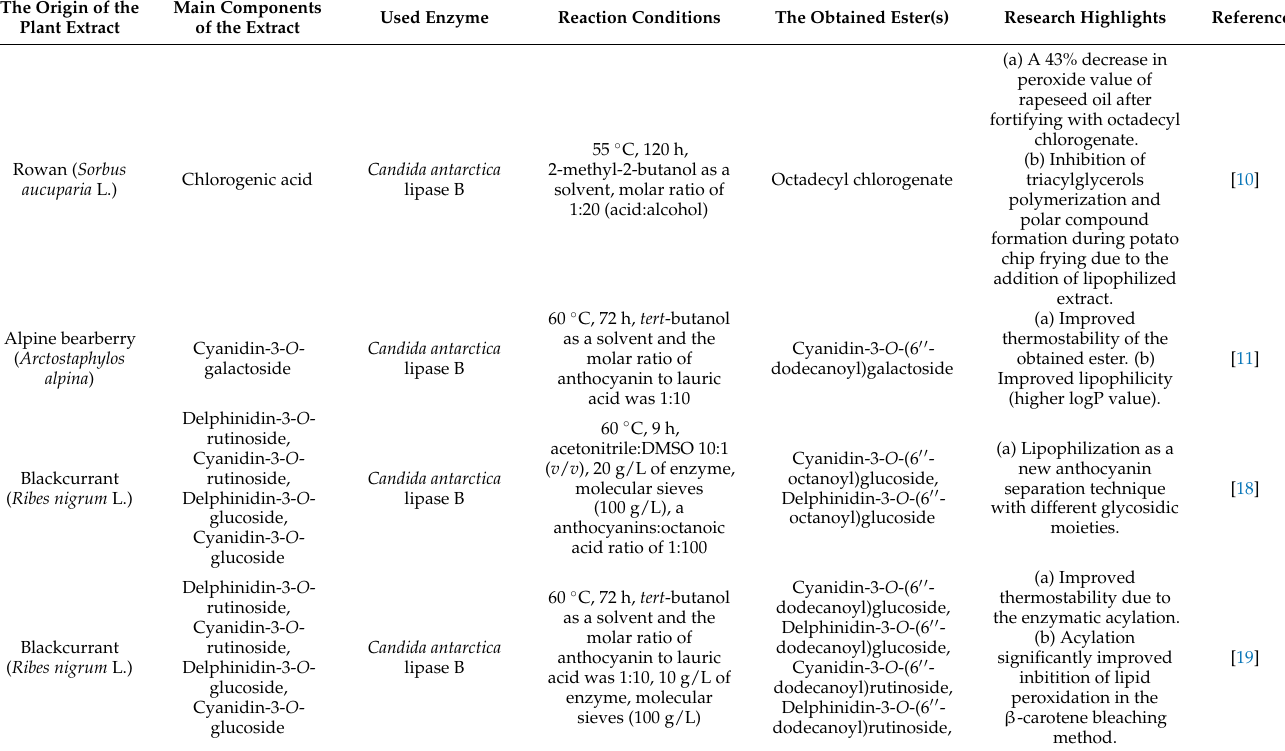
Table 1. Plant extracts from fruits used in enzymatic modifications of phenolic